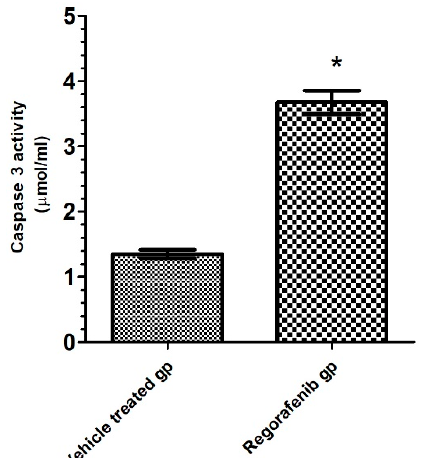
Figure 7. ( a ) Amplification plots of LC3-II and β -actin mRNA gene expression; ( b ) amplification plots of BECN1, p62, and GADPH mRNA gene expression.